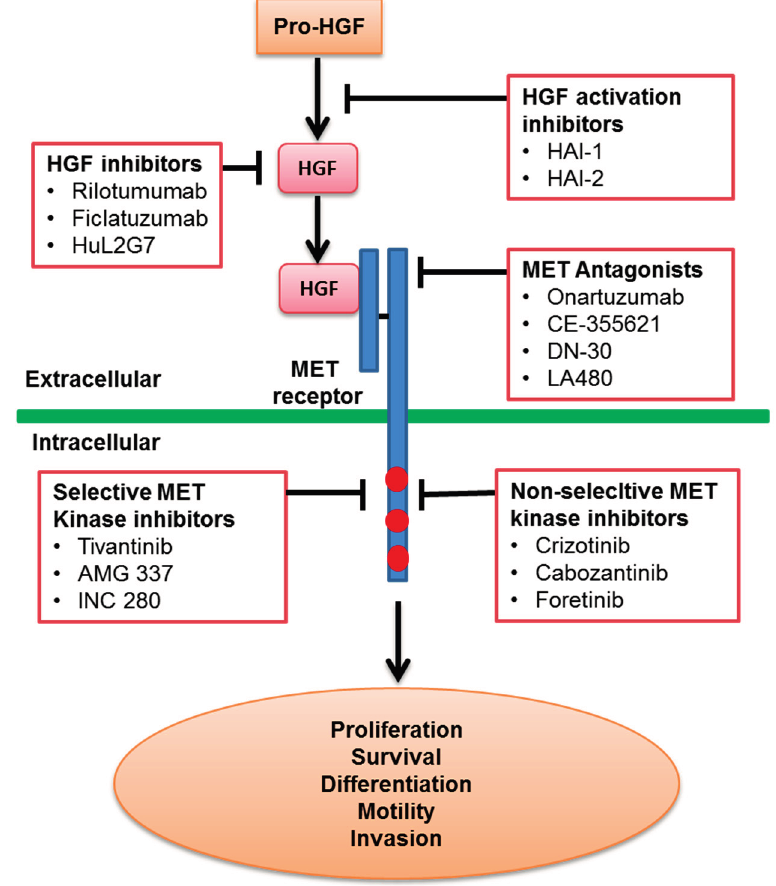
Figure 1. Representative examples of different mechanism classes of HGF and MET inhibitors. HGF: hepatocyte growth